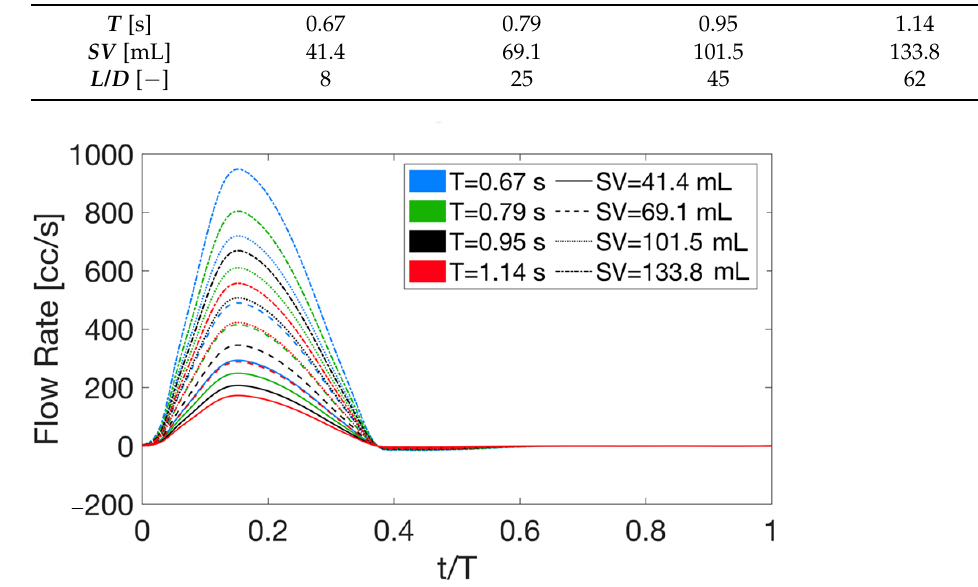
Table 1. Quadrature points for the parameters T , SV , and L / D .